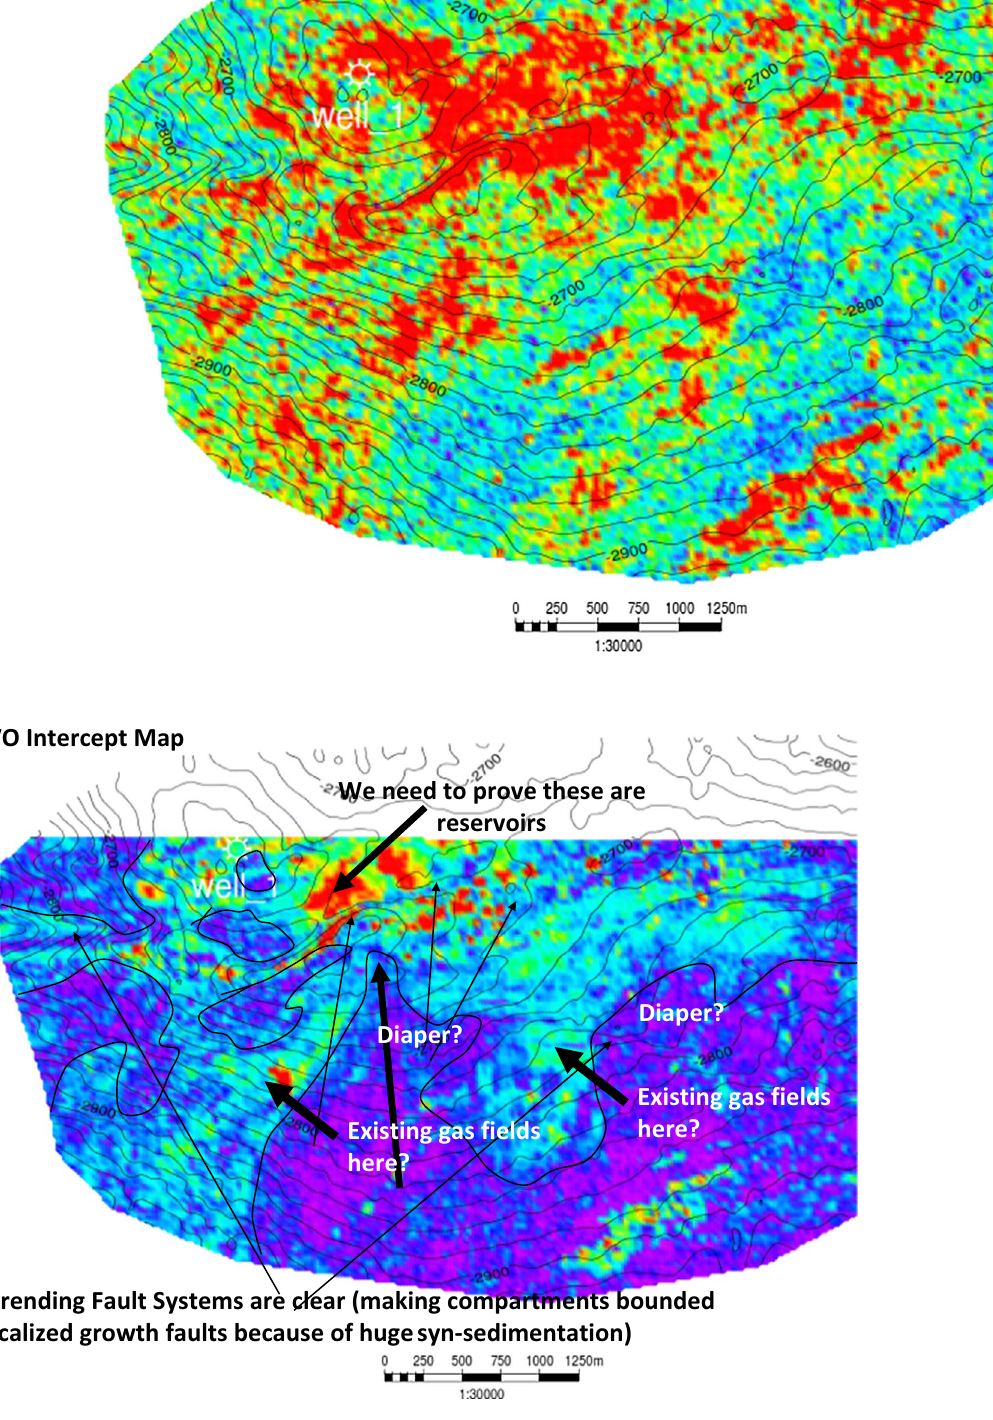
Fig. 7 AVO gradient superim- posed on two-way time contour map